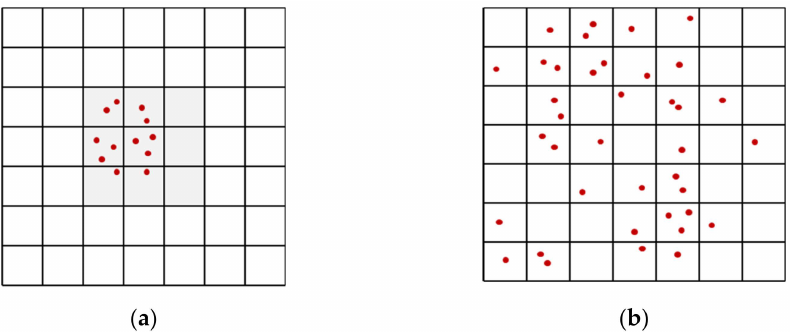
Figure 3. Spread of points across neighboring voxels (plan view): ( a ) Pole-like Object; ( b ) Tree Canopy (Group of